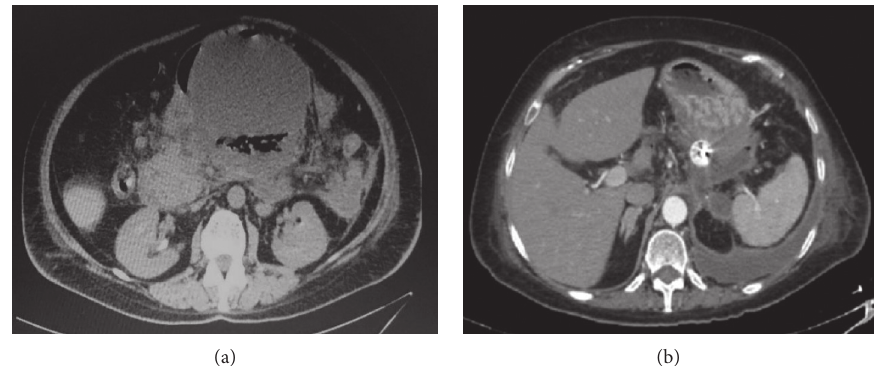
Figure 1: Abdominal CT scan showing (a) a huge pancreatic pseudocyst with air and fluid content and (b) resolution of most of the pseudocysts after AXIOS drainage.